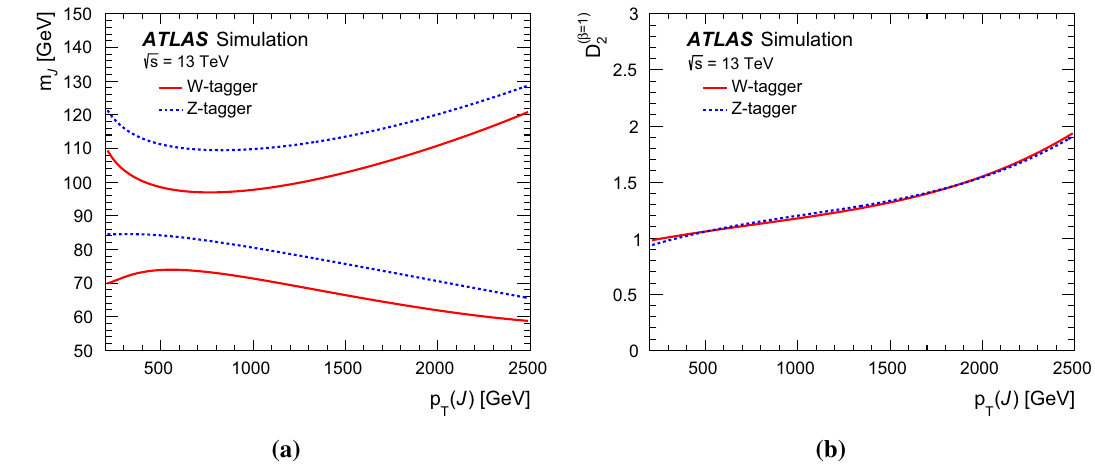
(β = 1 ) selecting the high (low)-purity signal regions as 2